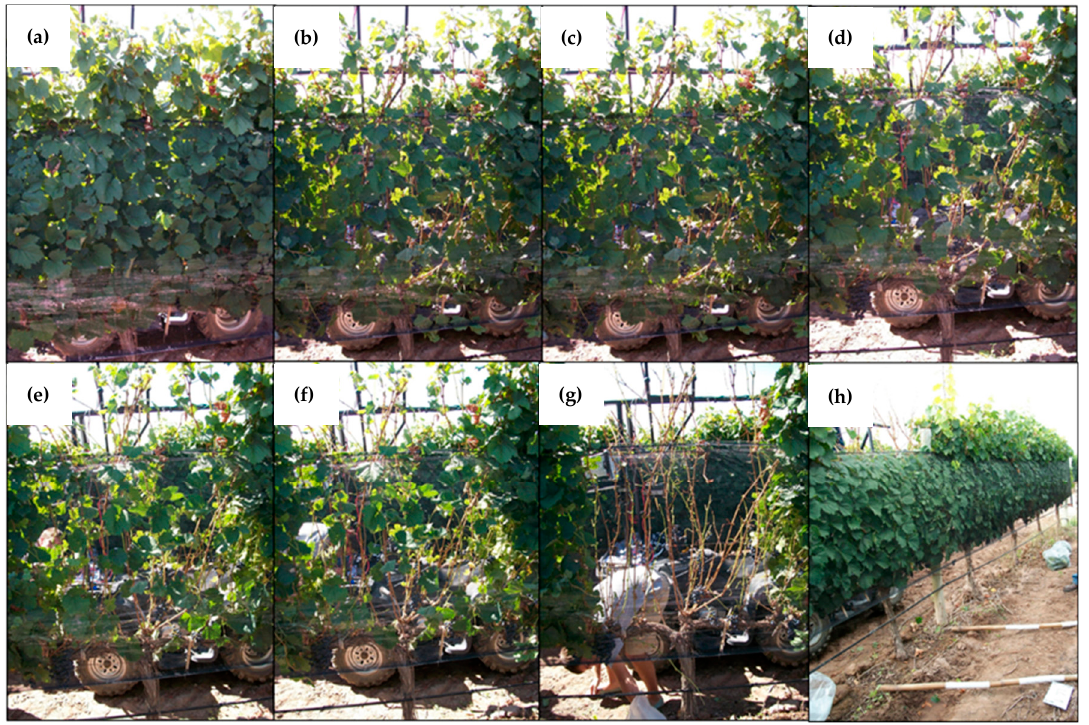
Figure 2. Defoliation procedure: ( a )–( g ) Progressive uniform defoliation of a hail-protected VSP, removing the netting to implement the defoliation (netting was reinstalled before each image capture); and ( h ) Stepwise progressive defoliation of a hail-protected VSP; in this case, the netting remained installed and shoot tips extending over the net were defoliated first to simulate tipping, and canopy under the netting was defoliated later.